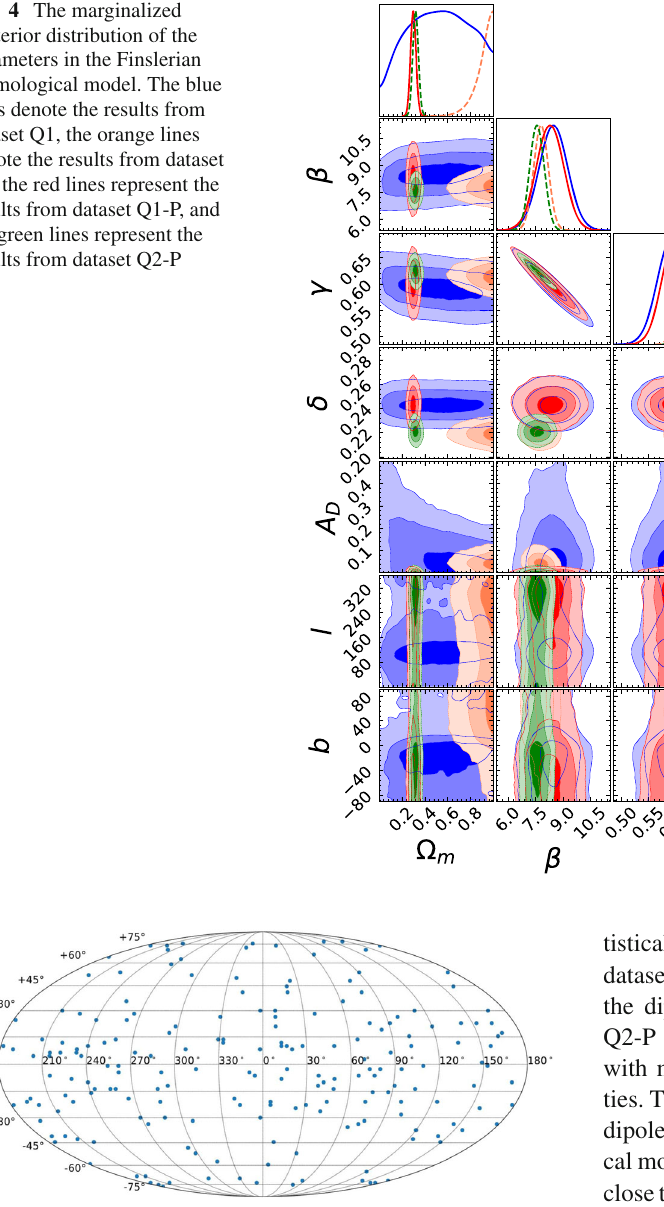
the dataset Q2-P and the combination of quasar and Pantheon samples, respectively. The results are similar to ones of the simulations based on the dataset Q1-P.